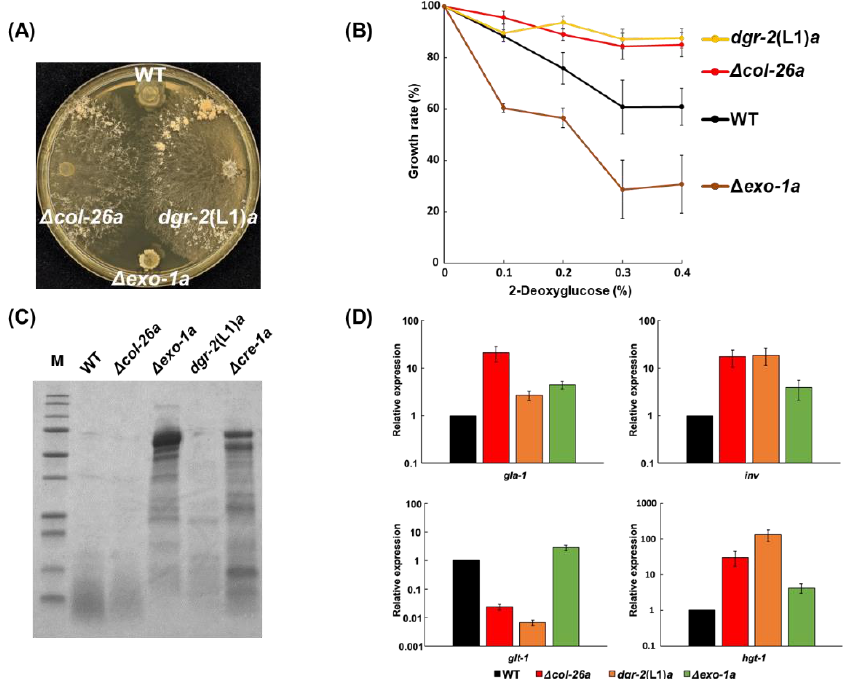
Figure 7. Comparison of the phenotypes of the exo-1 S11L ( dgr-2 (L1) a ) and Δ exo-1a mutants. Sorbose resistance ( A ) and 2-DG resistance ( B ) of wild-type, Δ col-26a , exo-1 S11L ( dgr-2 (L1) a ), and Δ exo-1a strains. ( C ) SDS-PAGE analysis of proteins secreted by each strain. The extracellular protein in culture filtrates was concentrated and applied for SDS-PAGE analysis. ( D ) Gene expression of gla-1 , inv , glt-1 , and hgt-1 under glucose-rich conditions (see Figure 5) in each strain. Errors are expressed as the standard error.